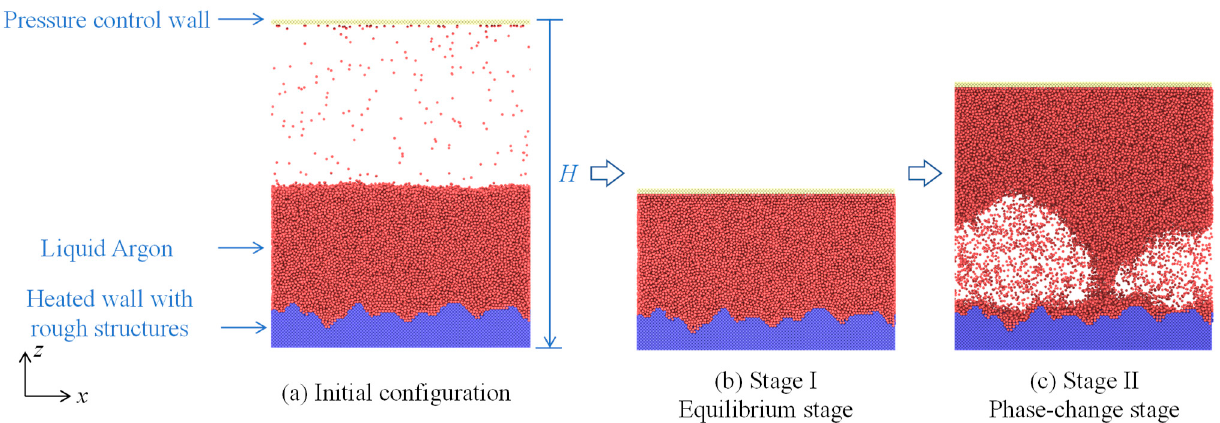
Figure 1. Simulation system set-up and simulation procedures. ( a ) Initial configuration of the simulation system; ( b ) Stage I of the simulation: Equilibrium stage; ( c ) Stage II of the simulation: Phase–change stage. Table 1. Potential energy parameters.